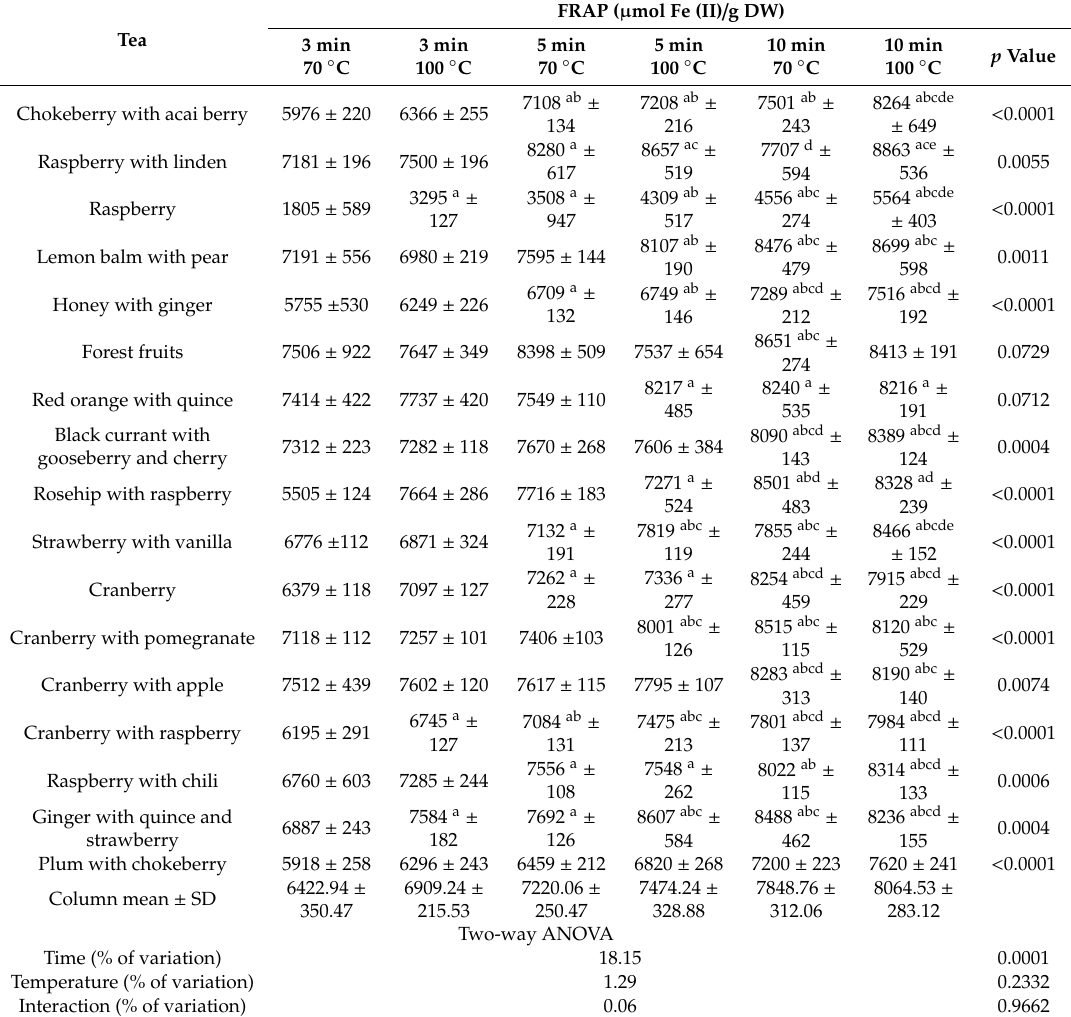
Table 4. Ferric Reducing Antioxidant Power (FRAP) in fruit tea infusions. a p < 0.05 vs. 3 min 70 ◦ C; b